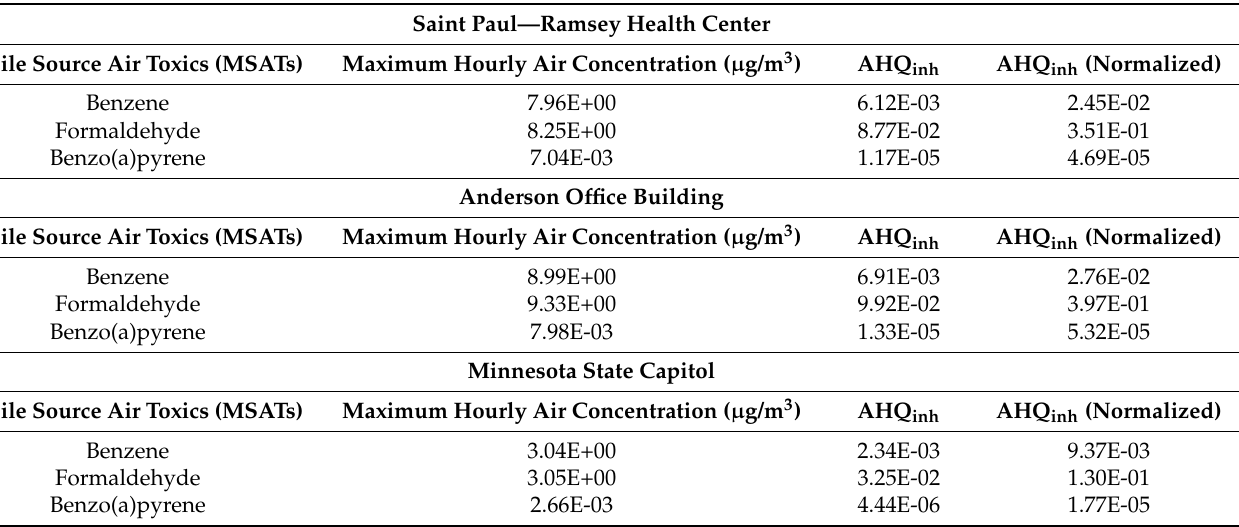
Table 13. Maximum Hourly Air Concentrations and Acute Hazard Quotient AHQ inh Results. Saint Paul—Ramsey Health